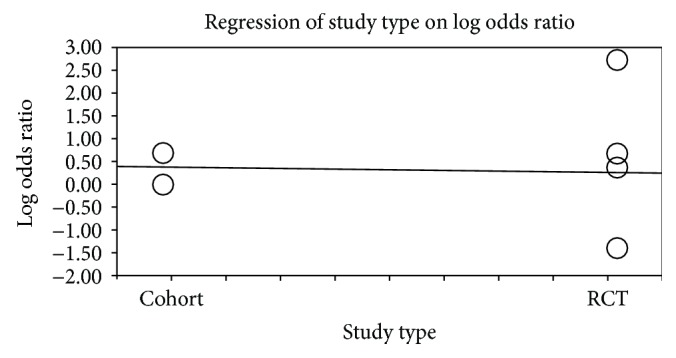
Plot of metaregression.